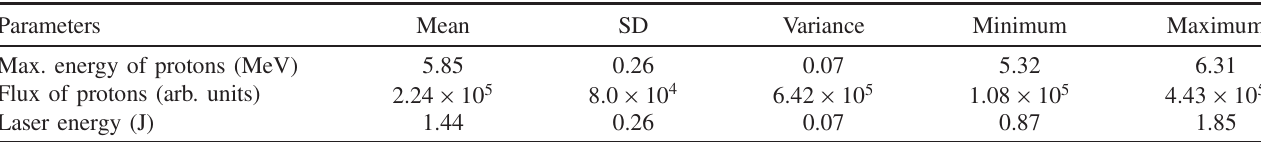
TABLE I. Statistics of proton beam parameters.